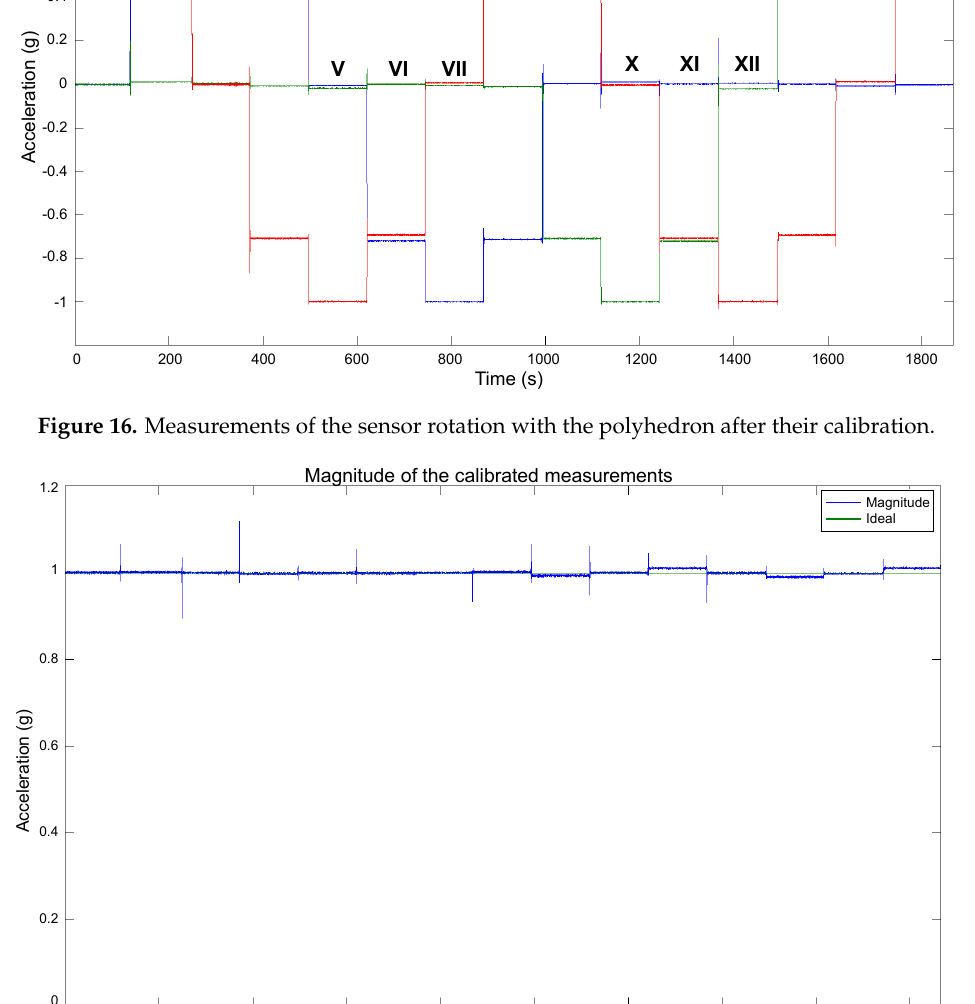
Figure 17. Magnitude of the measurements after the